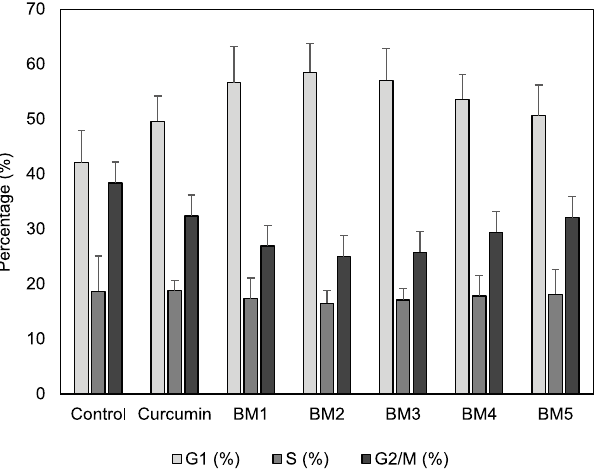
Figure 8. Flow cytometric analysis of the cell cycle. Curcumin analogues altered distribution of the AGS cells in cell cycle phases, which indicates that cell cycle arrested at G1